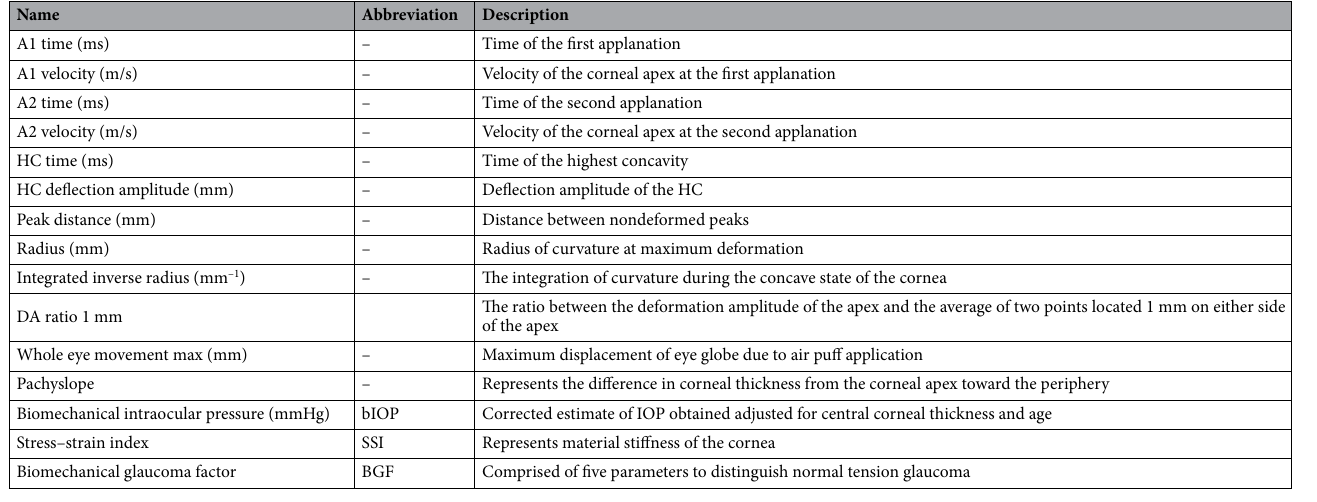
Table 1. Summary of Corvis-ST measured parameters. DA: deformation amplitude, HC: highest